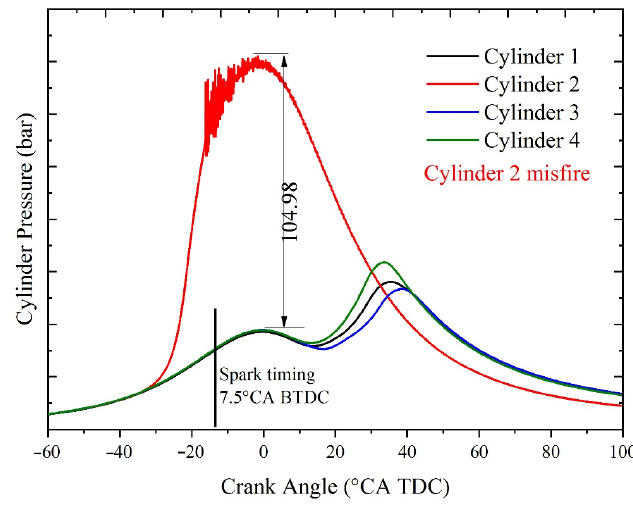
Figure 13. Pre ‐ ignition in the misfired cylinder. Figure 13. Pre-ignition in the misfired cylinder.